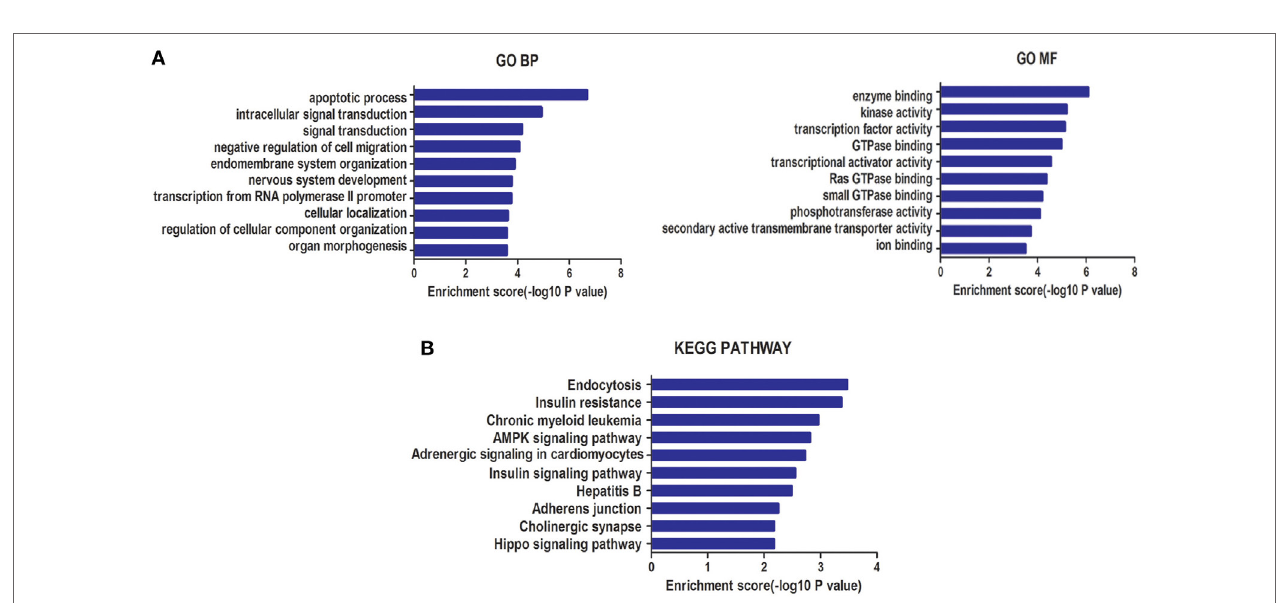
FigUre 3 | (a) Gene ontology (GO) analysis for genes targeted by two types of differentially expressed microRNAs (miRNAs): biological processes (BP) and molecular function (MF). (B) Kyoto Encyclopedia of Genes and Genomes (KEGG) pathway enrichment analysis for genes targeted by these two types of miRNAs. Both enrichment scores were calculated as the negative logarithm of a p value ( − Log p ). The top 10 significantly enriched items are listed for each